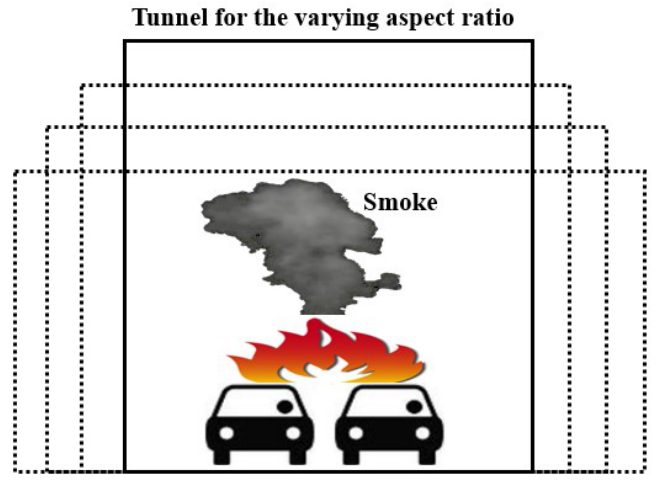
Figure 1. Schematic diagram of the basic concepts about varying aspect ratios of tunnels.